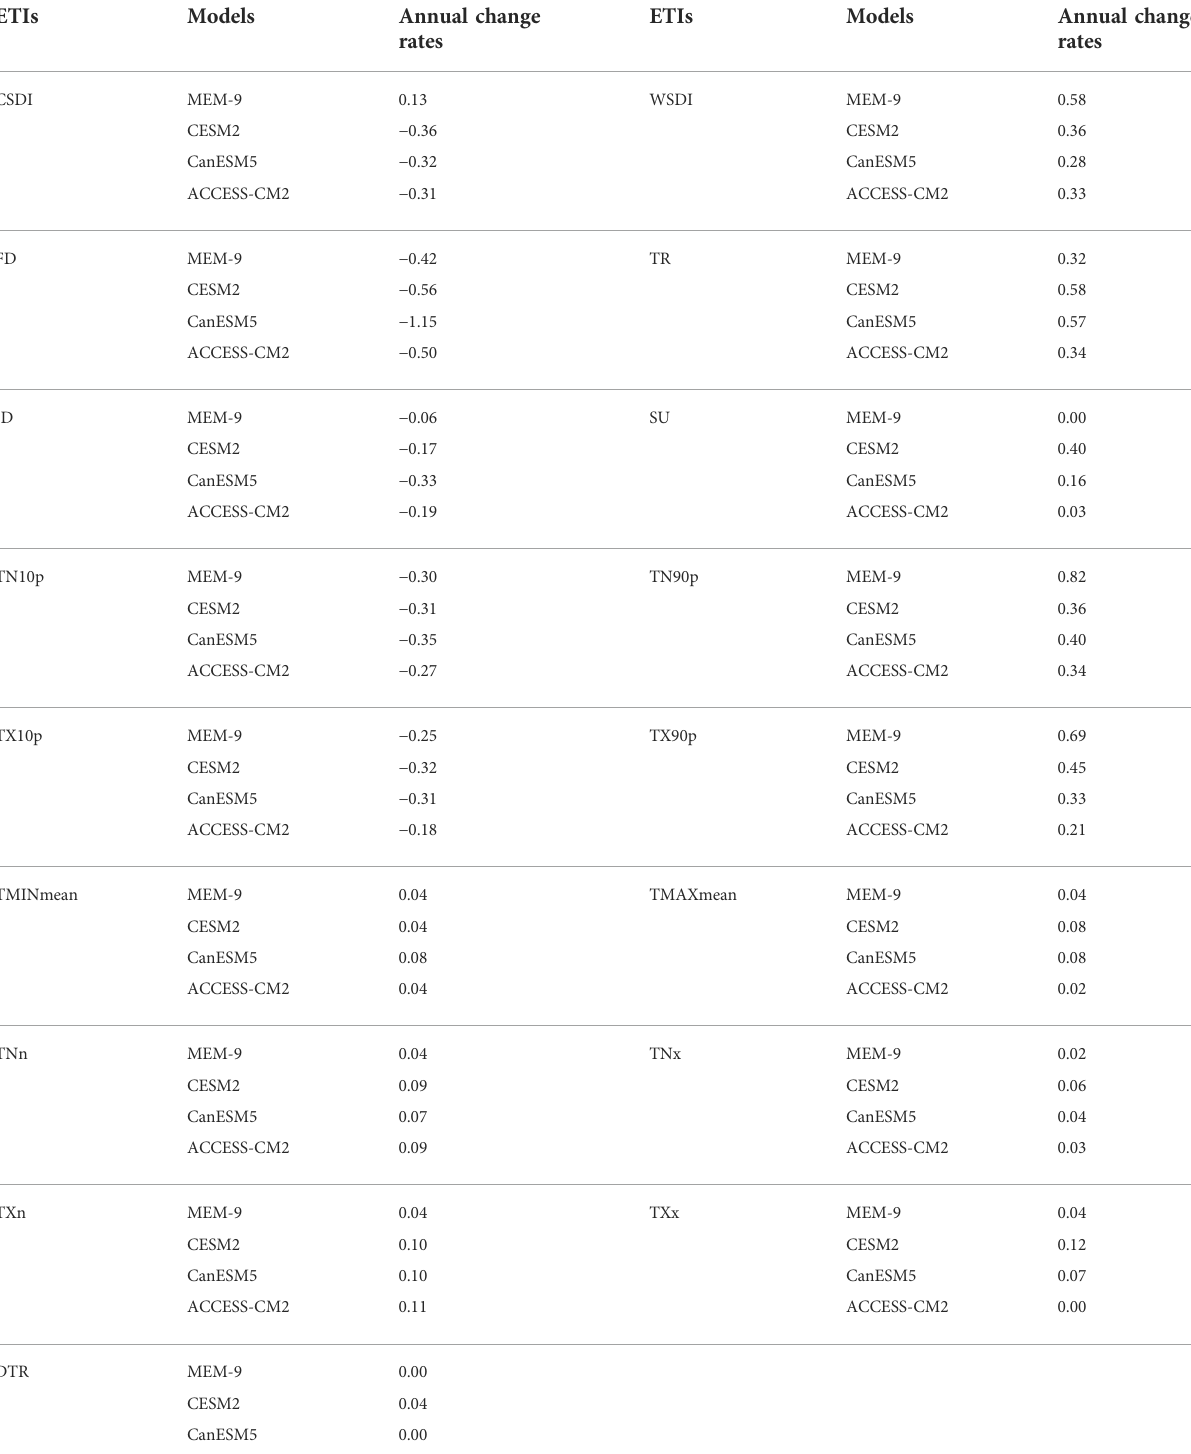
TABLE 5 Future projections of the annual change rates of 17 ETIs from 2021 to 2040 obtained with different models under the SSP2-4.5